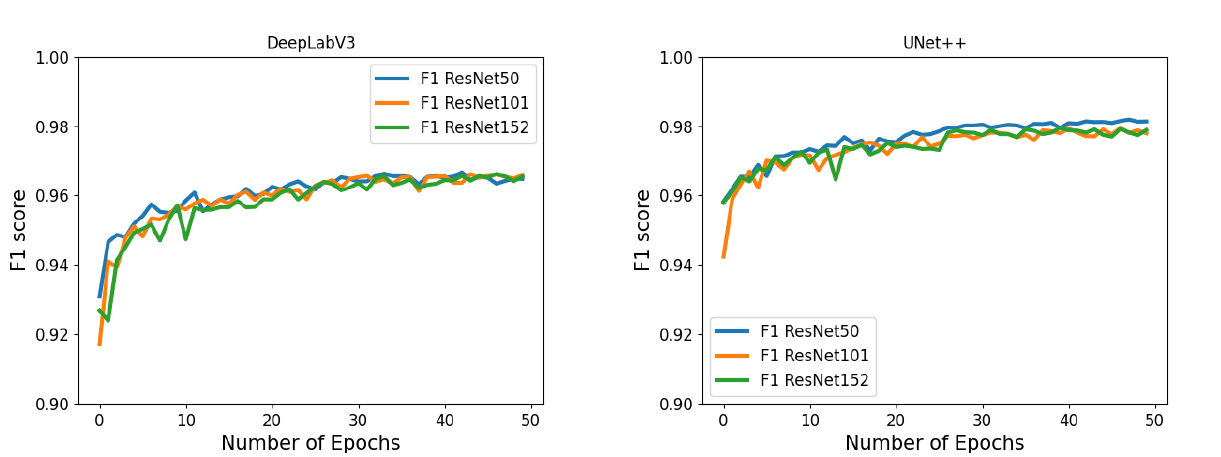
Figure 5 . F1 score for training with ResNet50(blue), ResNet101(orange) and ResNet152(green) for DeepLabV3 network.